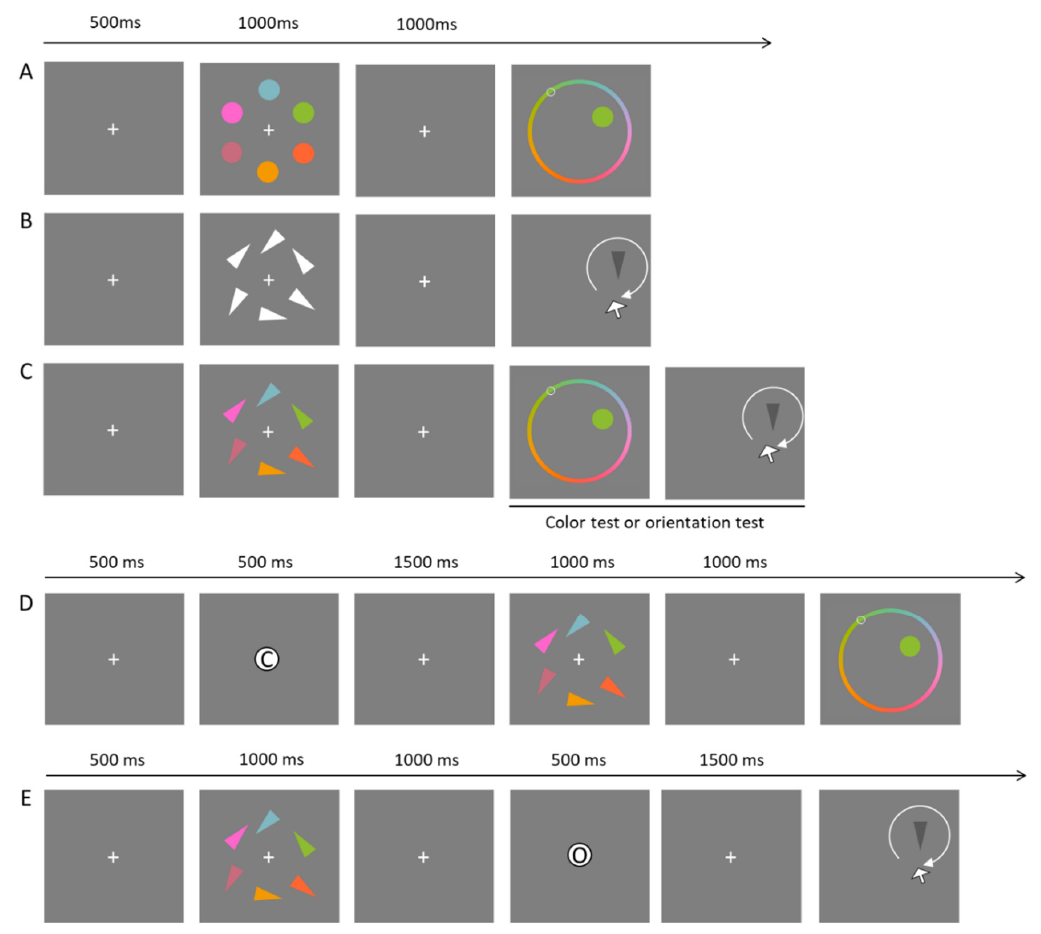
Figure 2. Example of conditions in Experiment 2. In Single-Feature baseline conditions, participants encoded only colors ( A ) or the orientation of the triangles ( B ) and then they indicated the color of the target by clicking on the color wheel or the correct triangle’s orientation by moving the mouse to rotate the probe. In Dual-Feature baseline ( C ), participants encoded colored triangles, and then either the color or the orientation of an item was probed. In Filter condition ( D ), a cue was shown in the middle of the screen indicating the to-be-tested feature (C = color; O = orientation) before the onset of the memory array, allowing participants to only encode the relevant feature to WM. In Ignore condition ( E ), a cue was shown during the retention interval, thereby allowing participants to ignore one of the features already stored in WM.